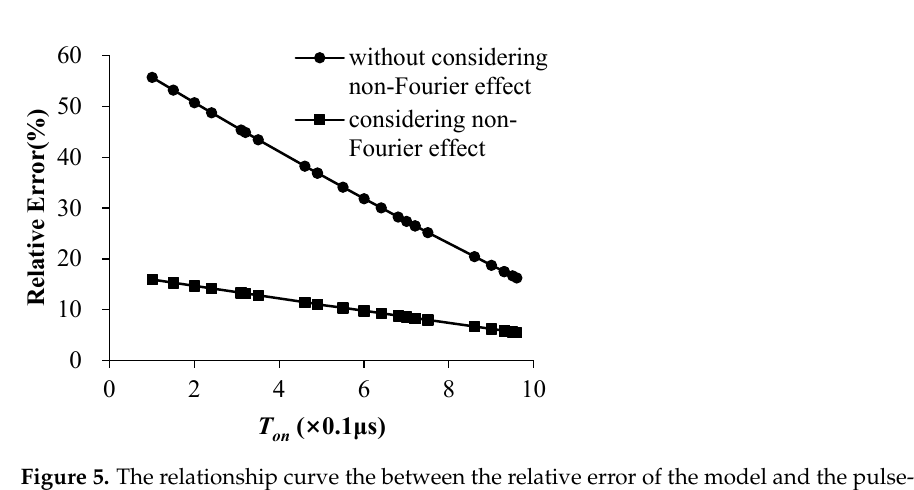
Figure 5. The relationship curve the between the relative error of the model and the pulse-on time.